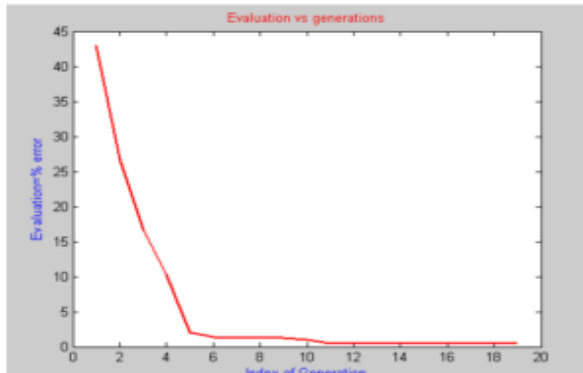
Figure 3: Error evaluation on the boundaries by Genetic algorithm.